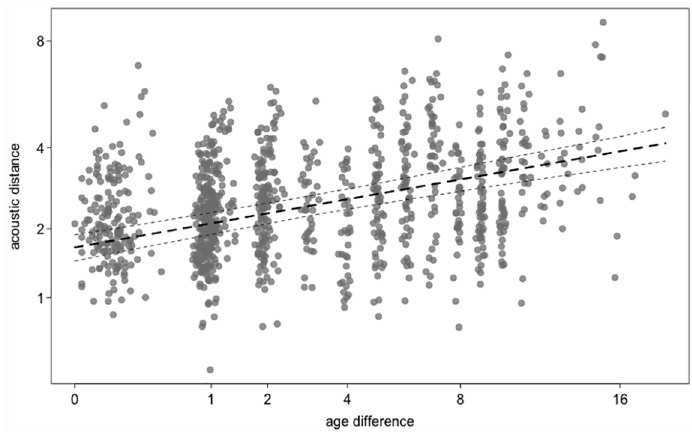
Fig 4. Acoustic distance vs. age difference. Acoustic distance plotted against age difference in years (at square root scale) within pairs of individuals (pooling the three levels of group-matrilineal membership). The dashed lines represent the model estimate for acoustic distance as a function of age difference (bold-dashed line) and the upper and lower confidence interval.